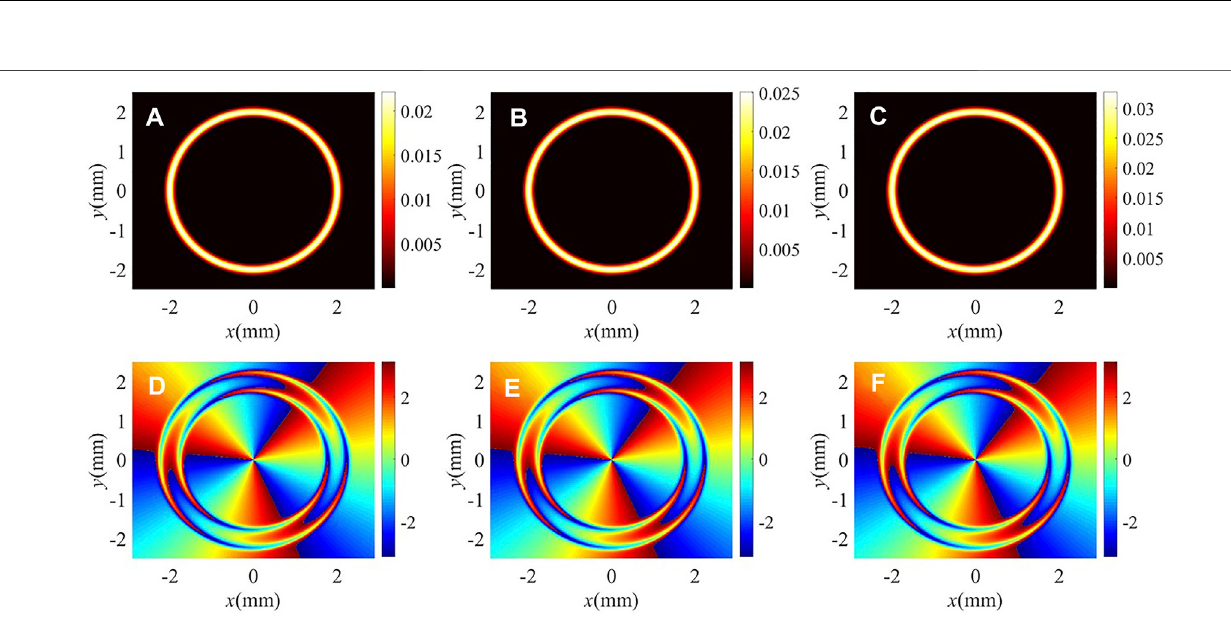
FIGURE 6 | (A – C) Intensity and (D – F) phase pro fi les of the FWM fi eld for different coupling detuning Δ c : (A,D) Δ c = 4 meV; (B,E) Δ c = 8 meV; (C,F) Δ c = 16 meV. Other parameters are the same as in Figure 4C .